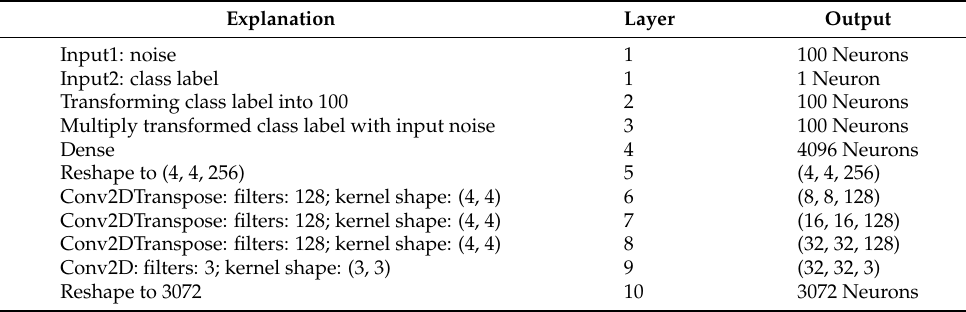
Table A3. The architecture of the generator used for the cifar10-based datasets.